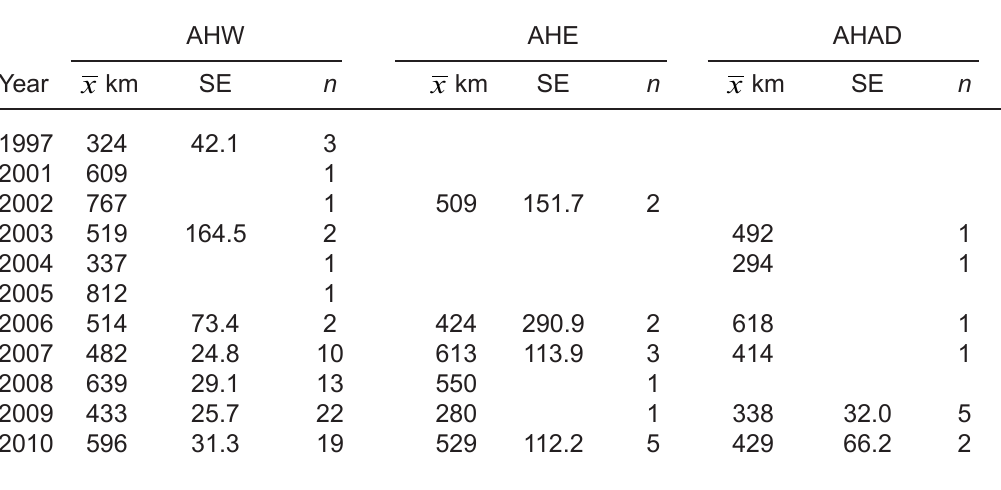
Table 9. Mean (standard errors) for straight-line distances between calving and winter locations for the Ahiak west (AHW), east (AHE) and Adelaide Peninsula (AHAD),